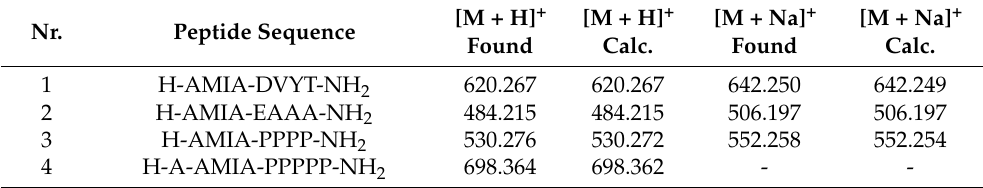
Table 1. MS data for the model peptides.